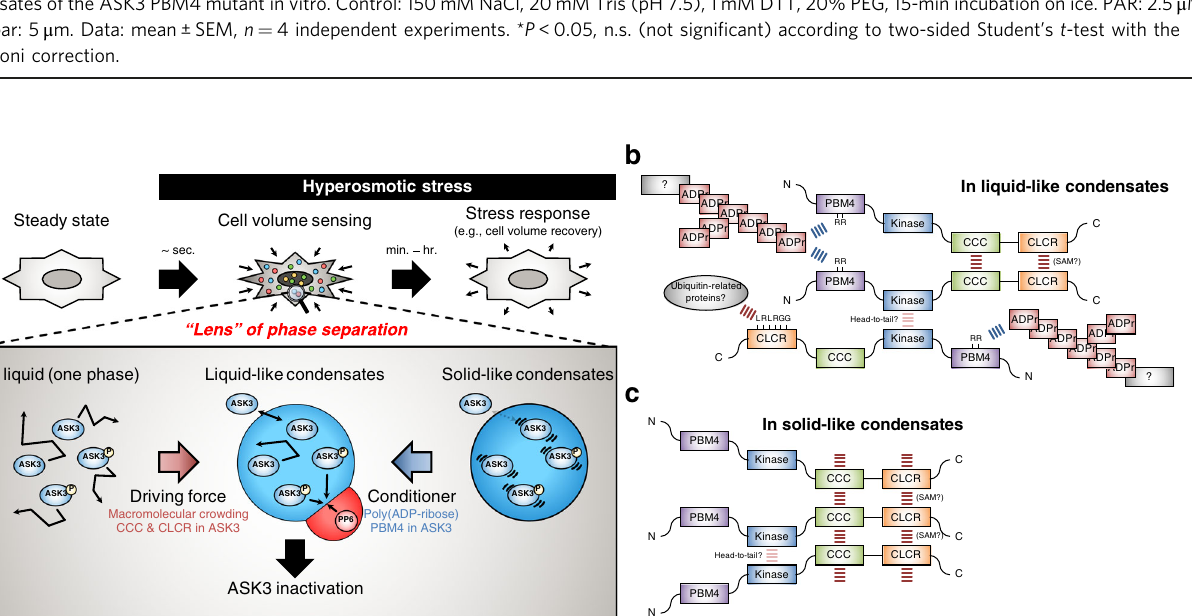
Fig. 7 Schematic summary of the main fi ndings and molecular mechanism models. a Schematic representation of the main fi ndings in this study. Under hyperosmotic stress, cells sense cell shrinkage immediately and induce appropriate responses to maintain homeostasis. By leveraging the “ lens ” of phase separation, we unveiled that cells rationally incorporate macromolecular crowding-driven phase separation into their osmosensing systems. In addition to the sensing machinery for osmotic stress, ASK3 condensates function as the speci fi c accelerator of ASK3 inactivation under hyperosmotic stress (at least). Unlike the roles in condensates of most RNA-binding proteins, poly(ADP-ribose) (PAR) endows ASK3 condensates with the liquid property and enables the PP6-mediated inactivation of ASK3. b , c A current schematic model for the molecular mechanism of ASK3 condensates under hyperosmotic stress. Under the excluded volume effect, the heterogenous multivalent modular interactions via C-terminus coiled-coil (CCC) domain and low-complexity region (CLCR) would drive the condensate formation of ASK3 (indicated as red bars). At the same time, the fl exible and bulky PAR would also multivalently interact with ASK3 via arginine residues in the PAR-binding motif (PBM4) of ASK3 and indirectly coordinate the multivalent modular interactions between ASK3 molecules, which would control the liquidity of ASK3 condensates (indicated as blue bars in b ). When the multivalent interactions between ASK3 and PAR are absent, the modular interactions between ASK3 molecules would be strong enough to drive the maturation of ASK3 condensates into the solid phase ( c